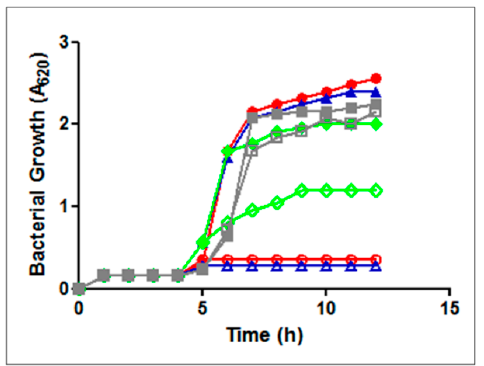
Figure 5. Growth of B. subtilis strains in minimal medium in the absence (solid symbols) or in the presence (open symbols) of 2 µ g of GE81112 added 4 h after inoculation. B. subtilis strains were: JH14115 opp + app + (blue); JH642 opp + app − (red); JH14116 opp − app + (green); and JH14115 opp − app − (gray).